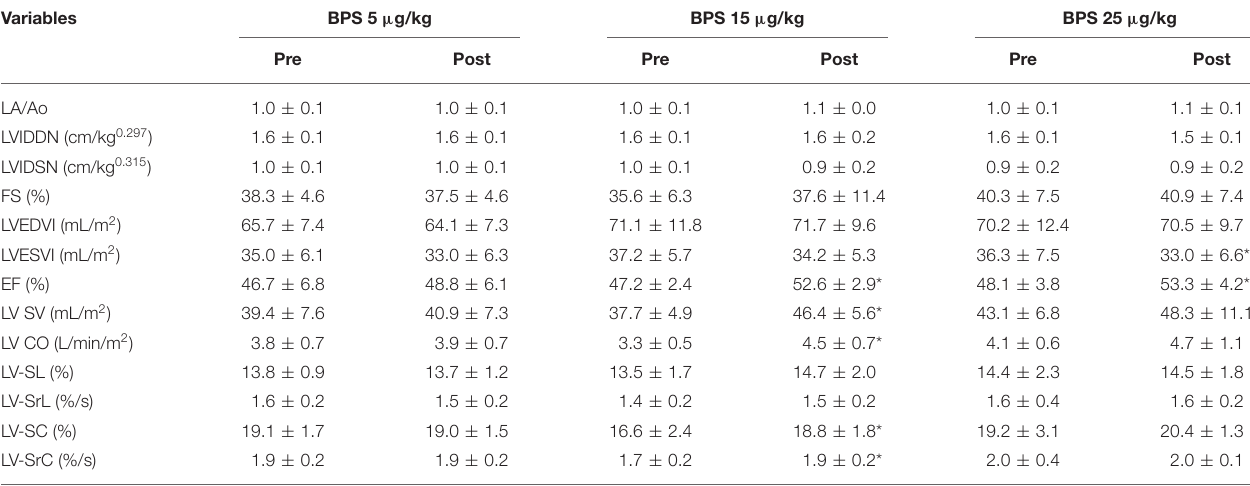
TABLE 3 | Changes in echocardiographic parameters for left heart morphology and function before and after beraprost sodium administration.